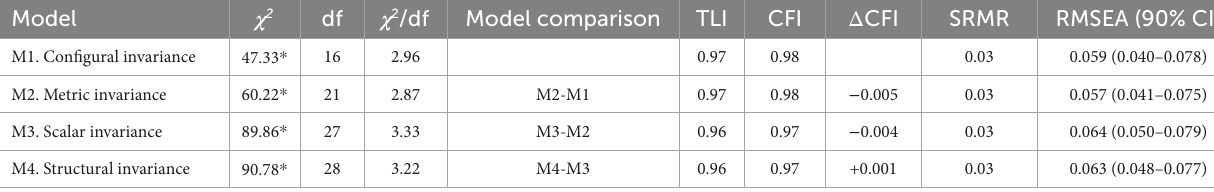
TABLE 5 Testing for factorial invariance of ARS_SCV across gender ( n = 569). Model χ 2 χ 2 /df Model comparison